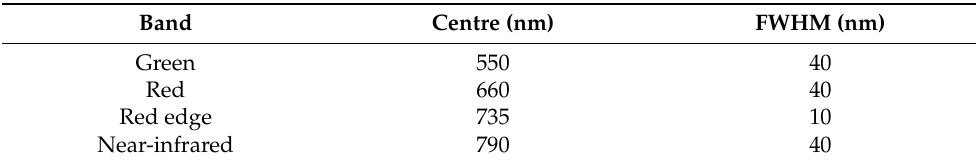
Table 1. Parrot Sequoia multispectral camera